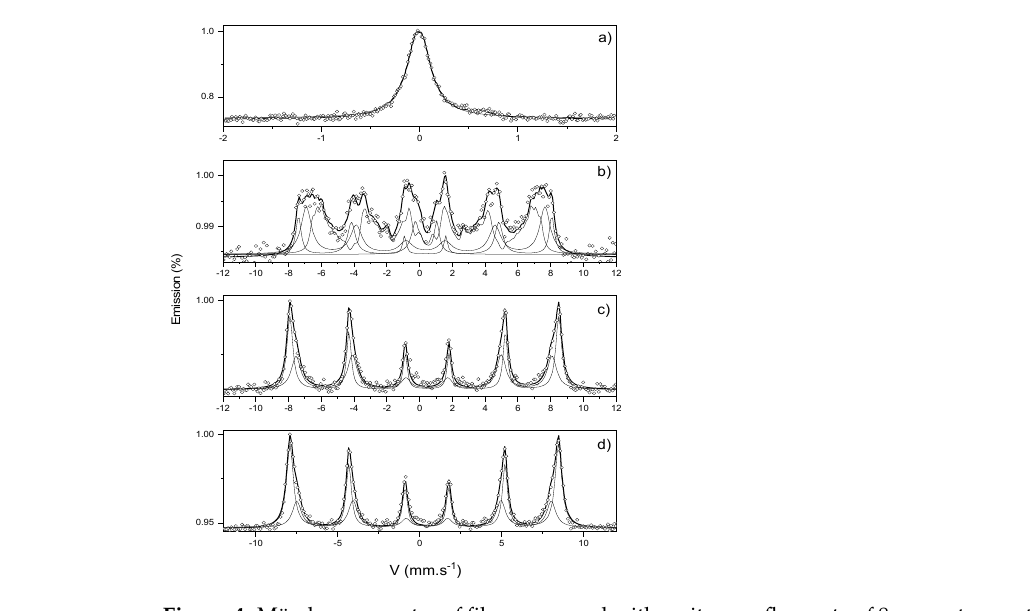
Figure 4. Mössbauer spectra of films prepared with a nitrogen flow rate of 8 sccm at room temperature 300 K. ( a ) Q (O 2 ) = 0 sccm, ( b ) Q (O 2 ) = 0.4 sccm, ( c ) Q (O 2 ) = 0.8 sccm, and ( d ) Q (O 2 ) = 1 sccm.